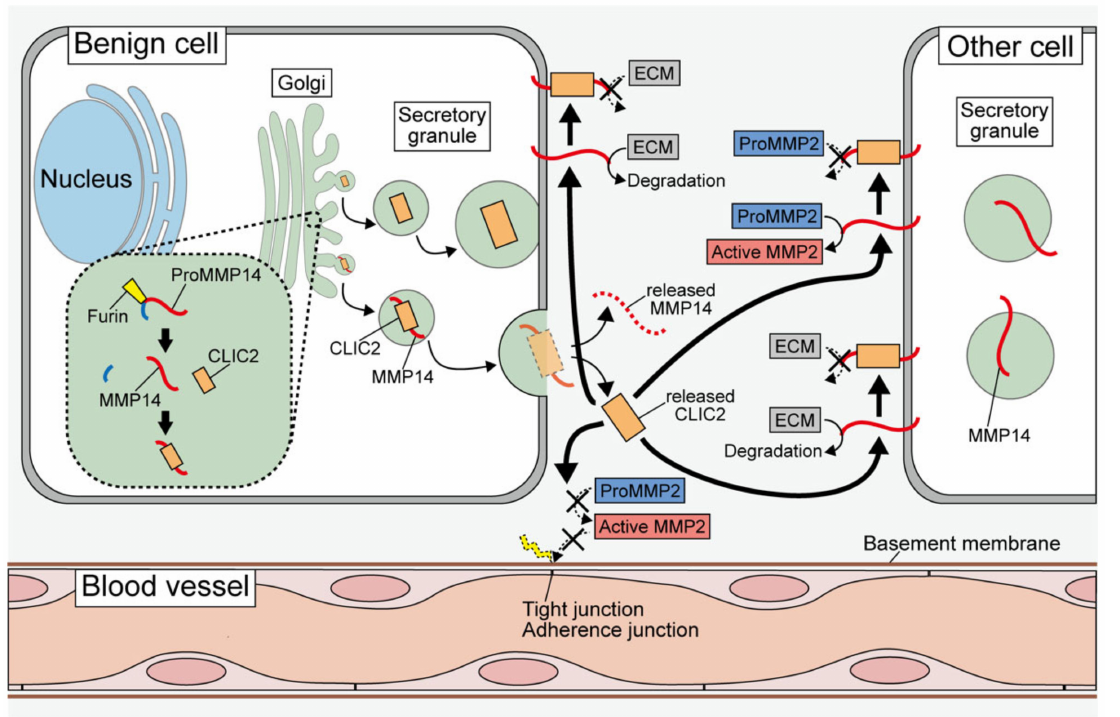
Figure 2. Probable mechanisms underlying the CLIC2-mediated suppression of tumor cell invasion and metastasis. CLIC2 is localized in the Golgi apparatus and secretory granules in benign tumor cells such as meningiomas. In the secretory granules, CLIC2 binds to MMP14 and inhibits the localization of MMP14 in the plasma membrane. Thus, proMMP2 is not activated by membrane-bound active MMP14. Furthermore, extracellular matrix (ECM) proteins are not degraded because of the inactive MMP2 and MMP14, and tight junctions and adherence junctions are not destroyed. Released CLIC2 binds to MMP14 on the surface of other cells while preventing the activation of MMP2 and ECM degradation. Thus, there may be two different mechanisms: intracellular and extracellular ones. For more detailed information, see papers